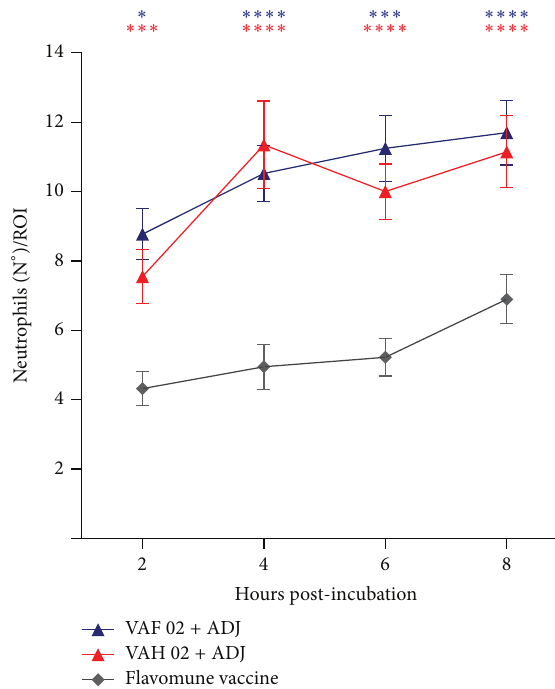
Figure 4: Comparison of the effects on the innate immune response between Flavomune vaccine and newly formulated vaccines. Graph quantifying neutrophil migration to the ROI for larvae bath- vaccinated with VAF-02-Fp + adjutant or VAH-02-Fp + adjutant, thus showing the activation of innate immune response. Statistical analysis was performed with a two-way ANOVA. Data represent the mean ± standard error from three independent experiments with 15 larvae each. ∗ 𝑃 value < 0.05, ∗∗∗ 𝑃 < 0.005 , and ∗∗∗∗ 𝑃 < 0.0001